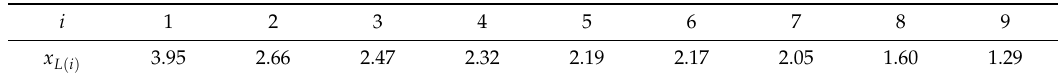
Table 2. Observed record values from Arctic sea ice